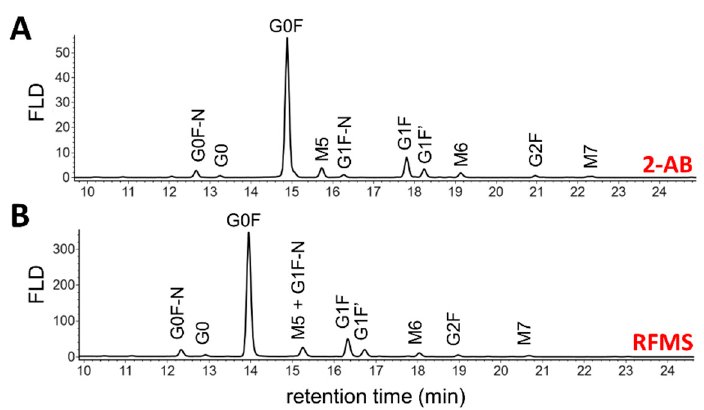
Figure 1. Fluorescence chromatograms of HILIC separated N- glycans of adalimumab after 2-AB ( A ) and RFMS ( B ) labelling. Different gradient profiles and mobile phase compositions were used for the HILIC analysis of the 2-AB and RFMS labelled glycans (see Section 2.4). Glycan identification based on calculated GU values and/or MS detection.